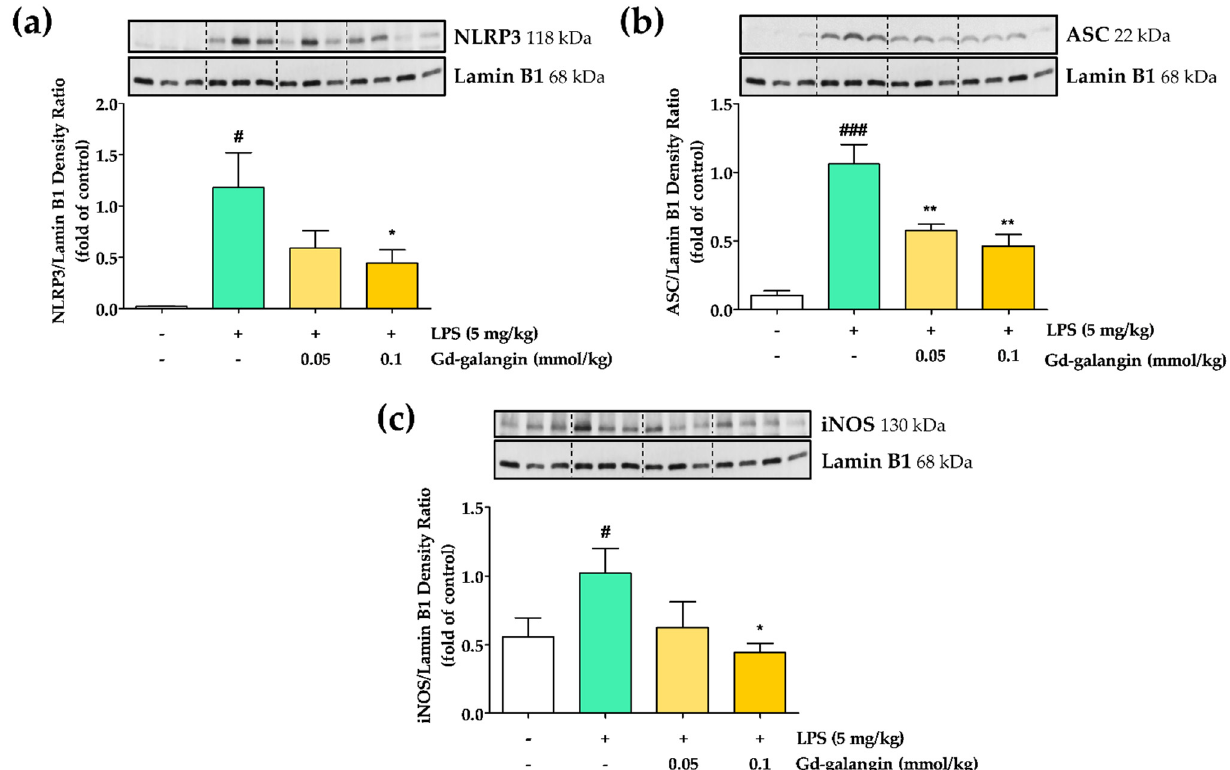
Figure 9. Anti-inflammatory effect in lipopolysaccharide (LPS)-induced thigh edema model. Thigh tissues were used to evaluate the expression of inflammatory factors with Western blot analysis. ( a , b ) shows about the expression of NLRP3-related factors. ( c ) shows about the expression of iNOS. (Data are shown as the mean ± SEM, t -test, n ≥ 3. # p < 0.05, ### p < 0.001 compared to control group; * p < 0.05, ** p < 0.01 compared to LPS-stimulated group).